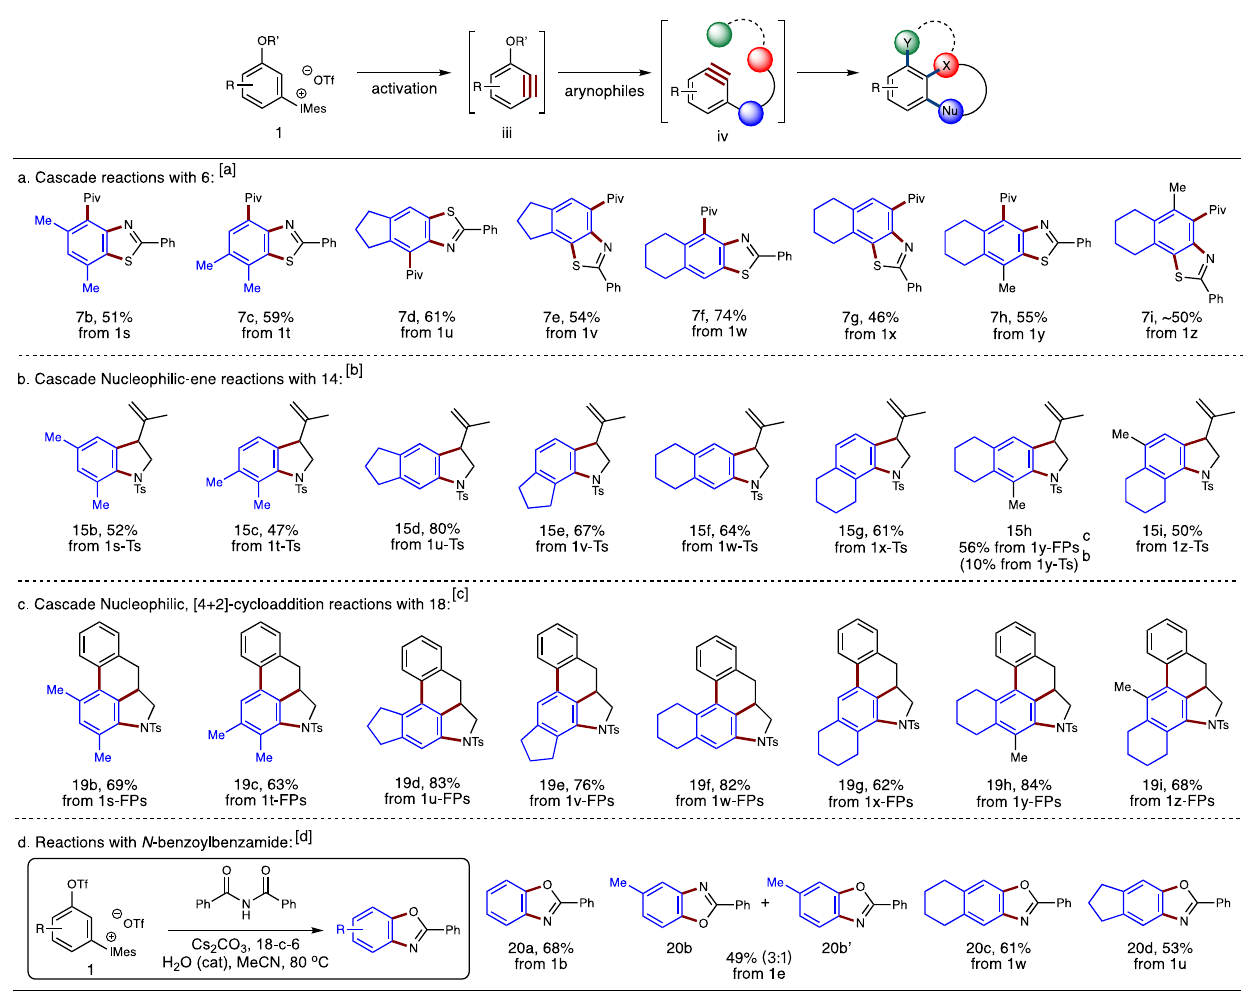
Fig.5|Preparationofdenselyfunctionalizedarenes.a Cascadereactionswith 6 . b Cascade nucleophilic-one reactions with 14 . c Cascade nucleophilic, [4 + 2]-